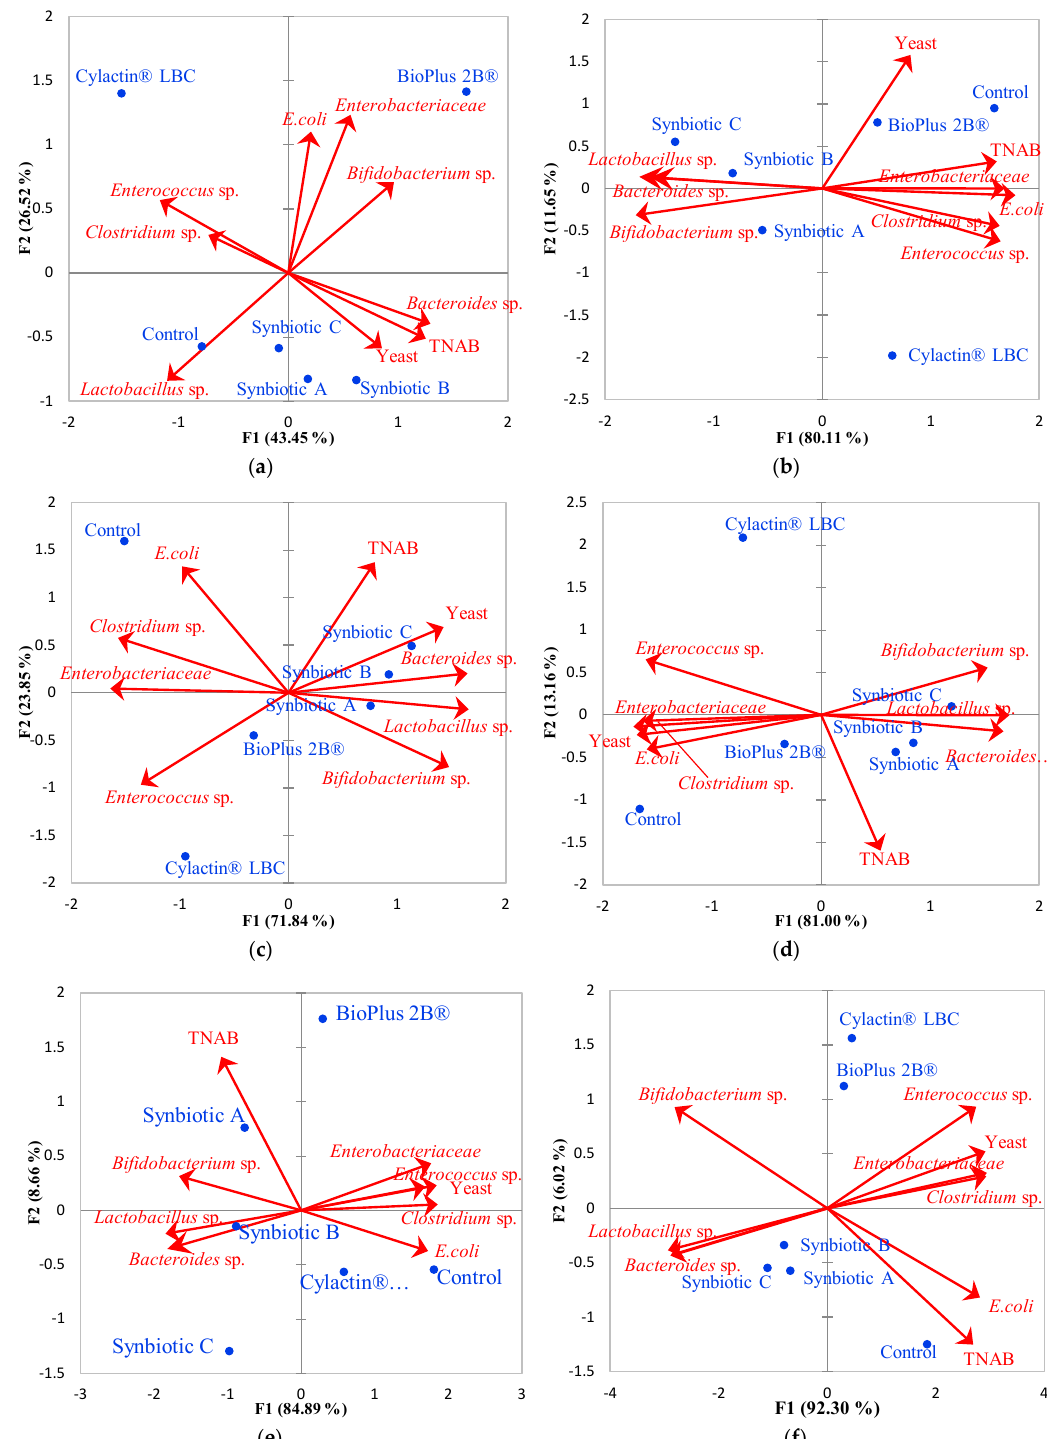
Figure 3. Correlation biplots which display the PCA results of the prevalent fecal microbiota (red vectors which represent variables) of pigs at a different age, which were administrated unmodified feed or with different additives (blue dots) and their impact on the microbial community (TNAB stands for the total number of anaerobic bacteria). Biplots were prepared for each sampling day: ( a ) 7th and ( b ) 28th day of life—piglets breastfed by sows; ( c ) 35th, ( d ) 68th, ( e ) 73rd, and ( f ) 165th day of life—feed additives administrated directly to weaned piglets.